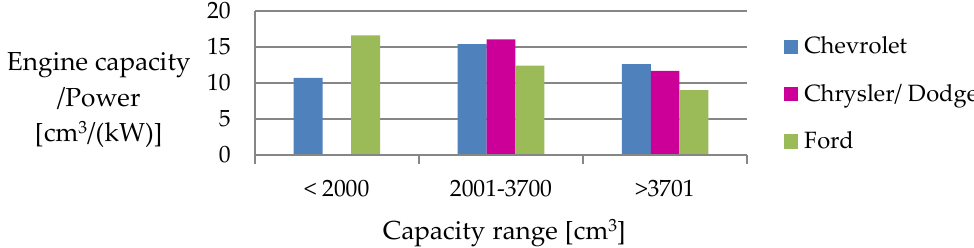
brands. Source: Developed own.